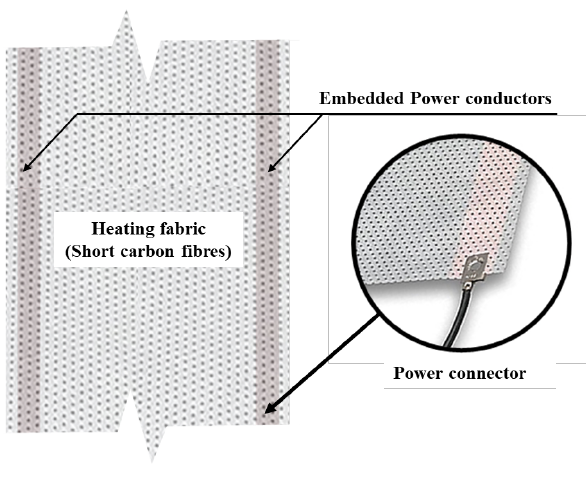
Figure 2: A section of LaminaHeat fabric embedded in the